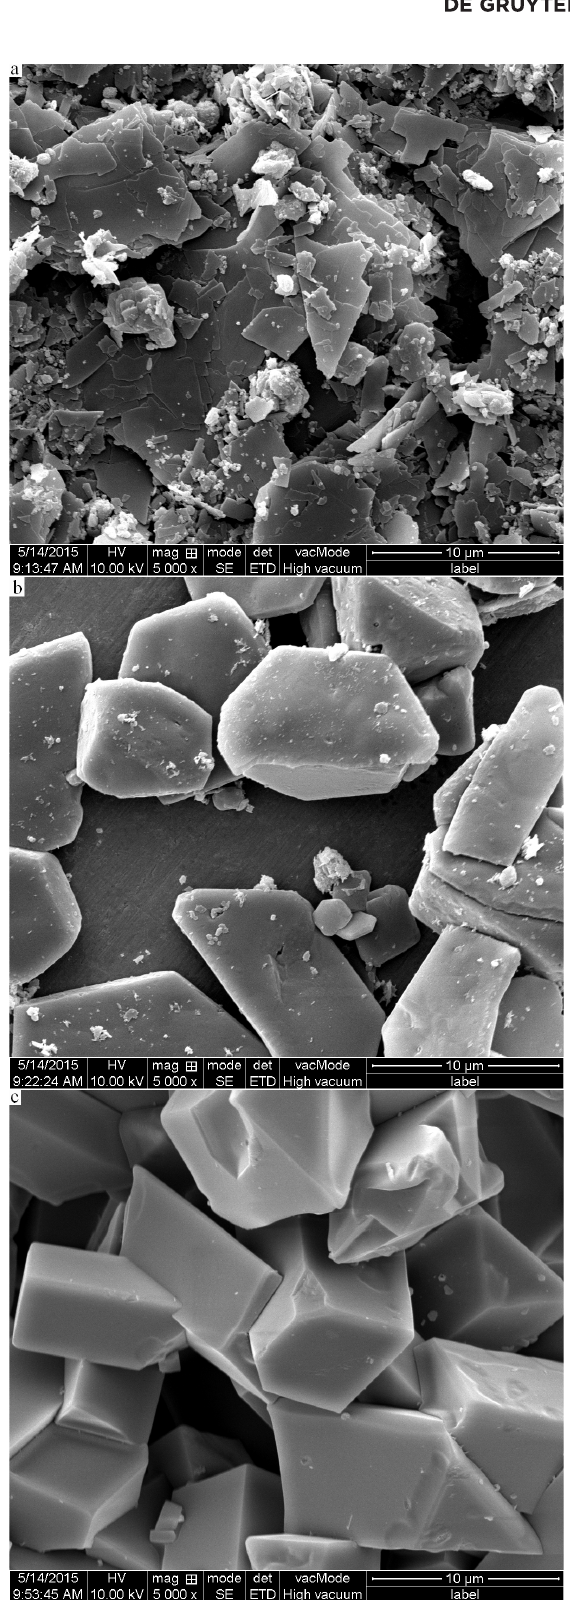
Figure 4: SEM of the crystal